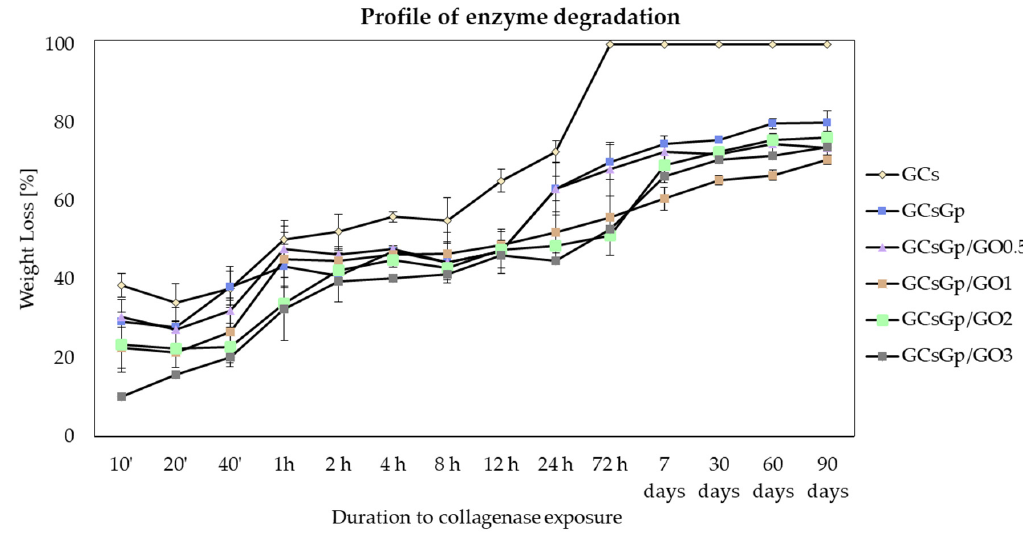
Figure 2. Degradation profile of GCs, GCsGp, GCsGp / GO 0.5%, GCsGp / GO 1%, GCsGp / GO 2%, and GCsGp / GO 3% in the presence of type II collagenase.